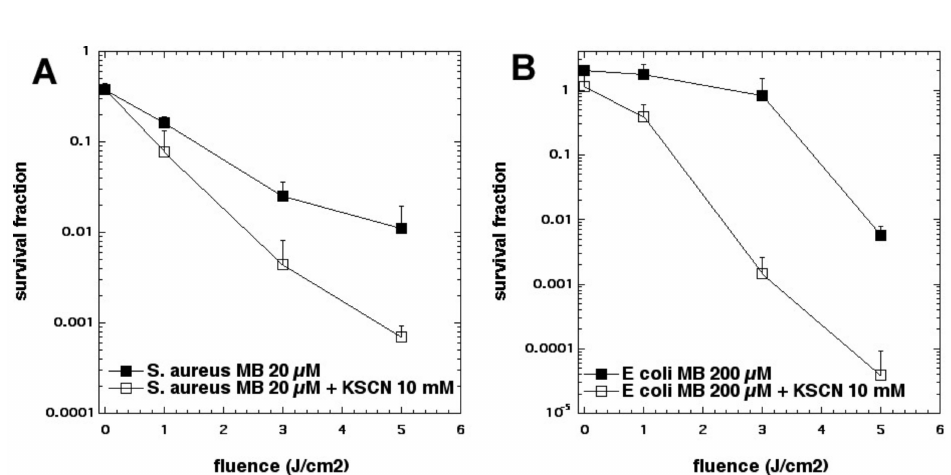
Figure 13. MB-mediated aPDI is potentiated by potassium thiocyanate. ( A ) S. aureus ; ( B ) E. coli . Figure adapted from data contained in [35].